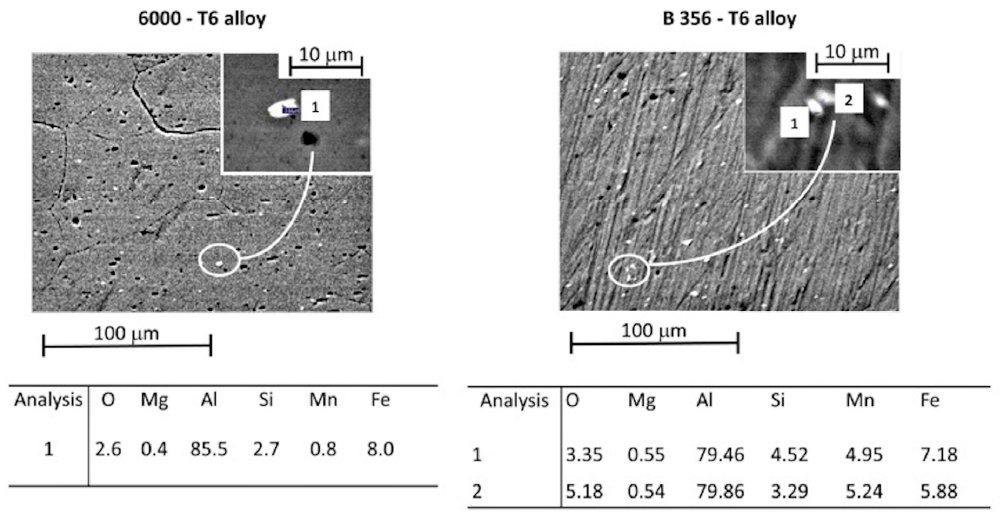
Figure 16. Some examples of the precipitate types in the PMZ: chemical composition in